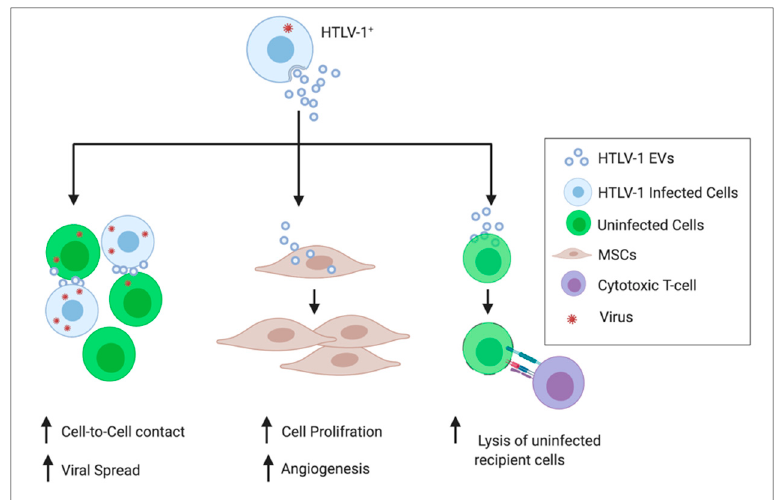
Figure 1. The effect of HTLV-1 EVs on uninfected recipient cells. HTLV-1 EVs could enhance cell-cell contact between HTLV-1-infected cells and uninfected T cells, thereby increasing viral spread. HTLV-1 EVs supports cancer progression by inducing the proliferation and angiogenesis of mesenchymal stem cells (MSCs). Additionally, HTLV-1 EVs prompt the lysis of uninfected target cells by cytotoxic T-cells, potentially resulting in chronic inflammation. Figure adapted from